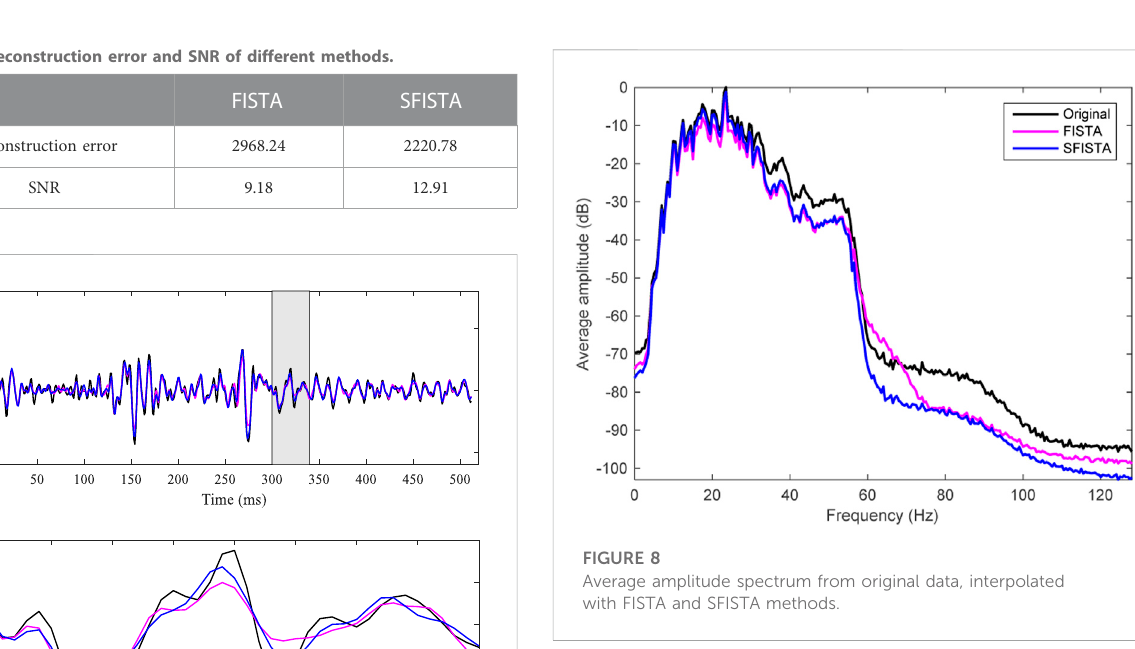
TABLE 6 Reconstruction error and SNR of different methods.